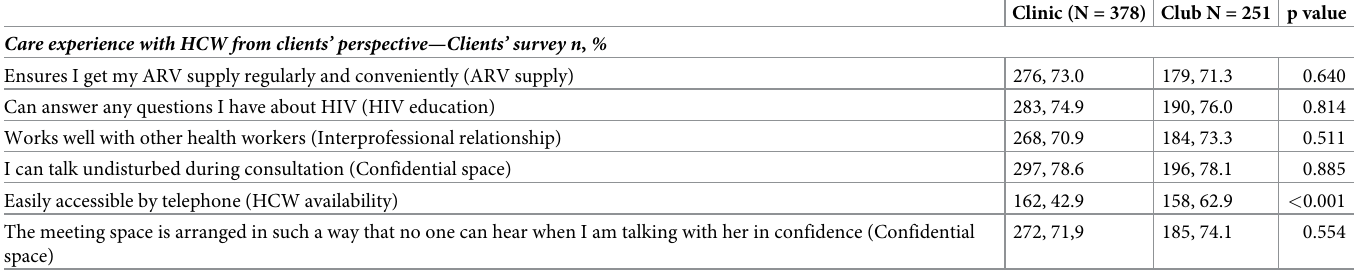
Table 3. Structure of care: Clients’ perspective on care